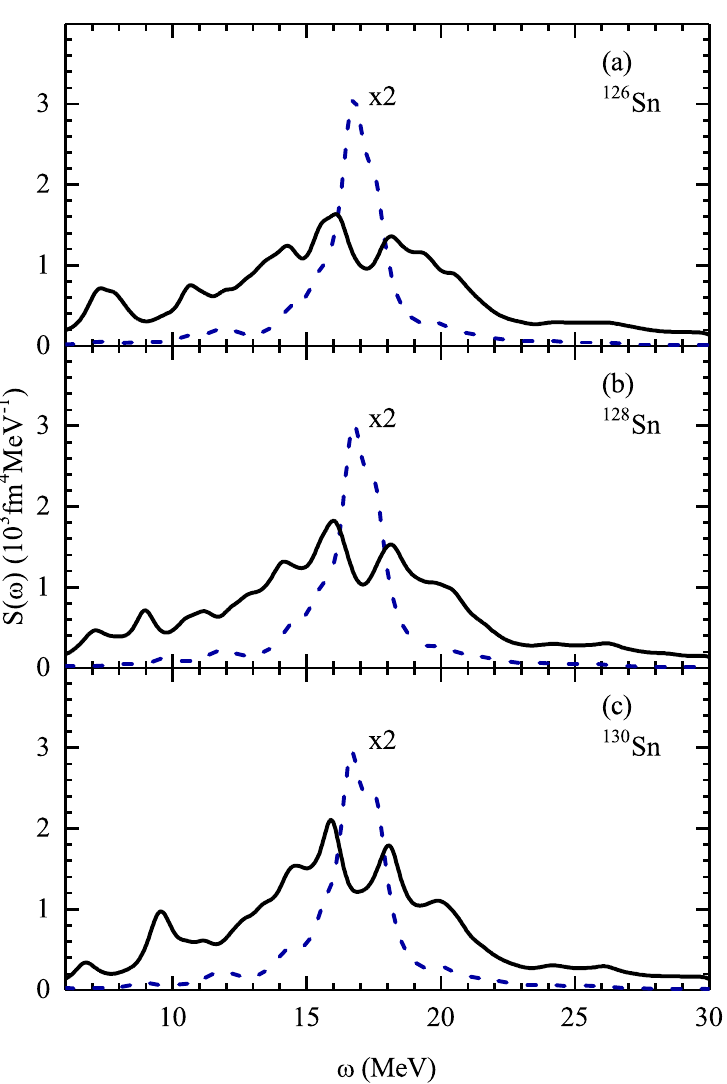
Figure 3. As in Figure 1, for 126 Sn (panel ( a )), 128 Sn (panel ( b )), and 130 Sn (panel ( c )), the distributions were calculated with the Skyrme force